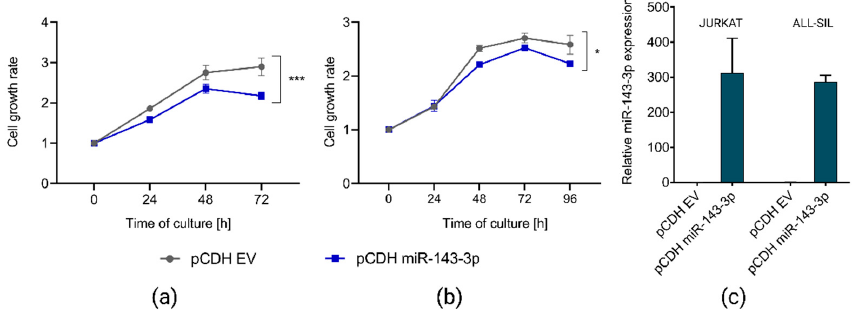
Figure 3. Effects of overexpression of miR-143-3p in JURKAT and ALL-SIL T-ALL cell lines. Decreased growth of JURKAT ( a ) and ALL-SIL ( b ) cells, as demonstrated by CCK8 assay. Cell growth rates were calculated as fold change of OD450 for each examined time point in reference to the starting point (0 h). pCDH EV, empty vector used as a control; *** p < 0.001; * p < 0.05 ( p -value calculated by two-way ANOVA for miR-143-3p expression as independent variable). RT-qPCR results demonstrating overexpression of miR-143-3p in both T-ALL cell lines upon transduction with pCDH miR-143-3p overexpression vector ( c ).